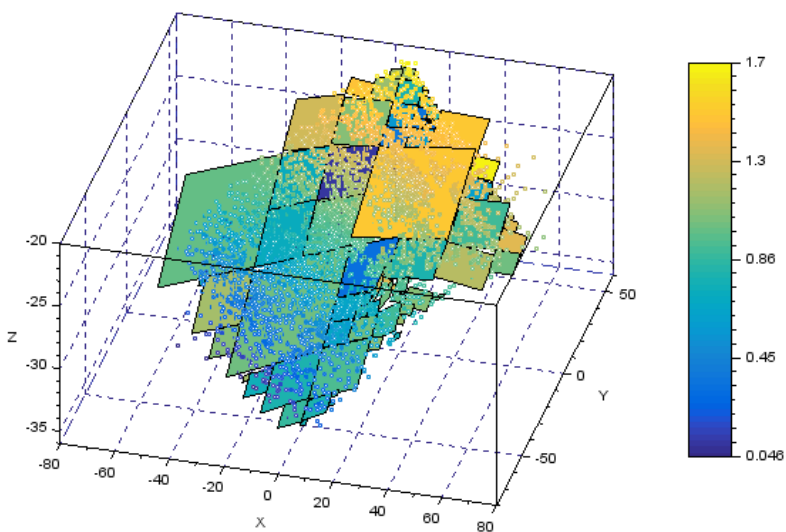
Figure 9. LIBAC data selection without propagation of the combined standard measurement uncertainty (CSMU). The point cloud is colored according to its elevation, and surface elements are colored according to their sensitivity function, as defined in the color bar. In this case, the Deming least-square (DLS) behaves like a principal component analysis (PCA) and the plane coefficient uncertainty is uniform.